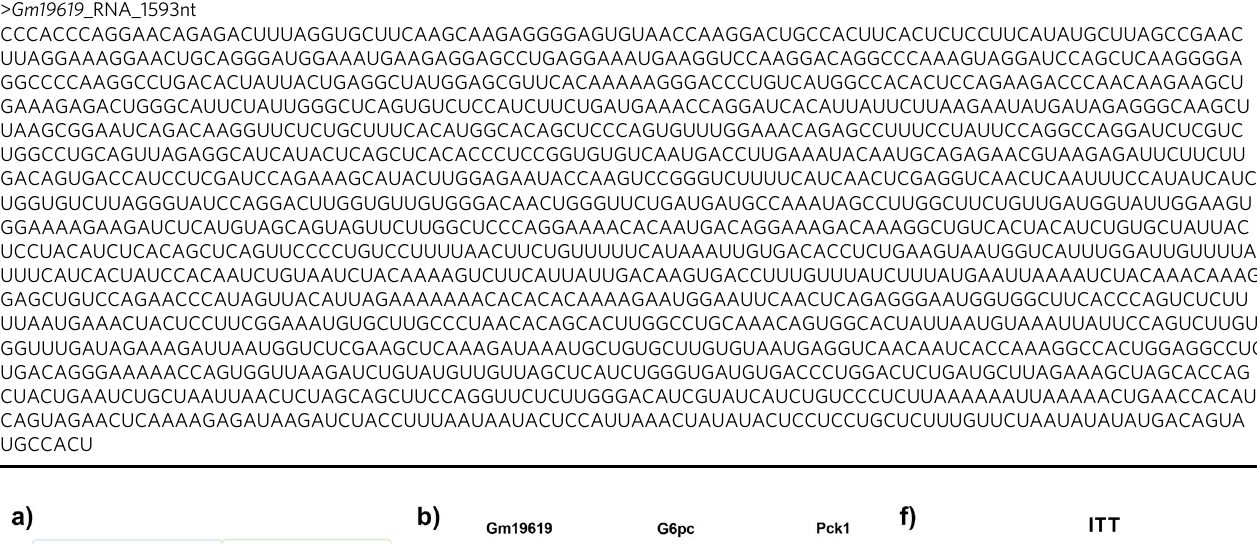
Table 1 RNA sequence of Gm19619 without a polyA tail.